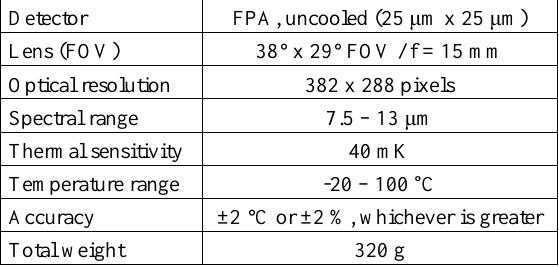
Table 1. Specifications of OPTRIS PI450 thermal sensor.